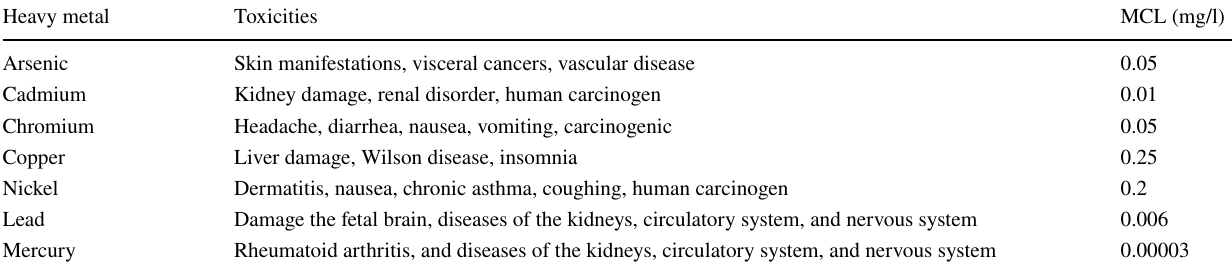
Table 10 The MCL standards for the most hazardous heavy metals. Source : Babel and Kurniawan (2003)